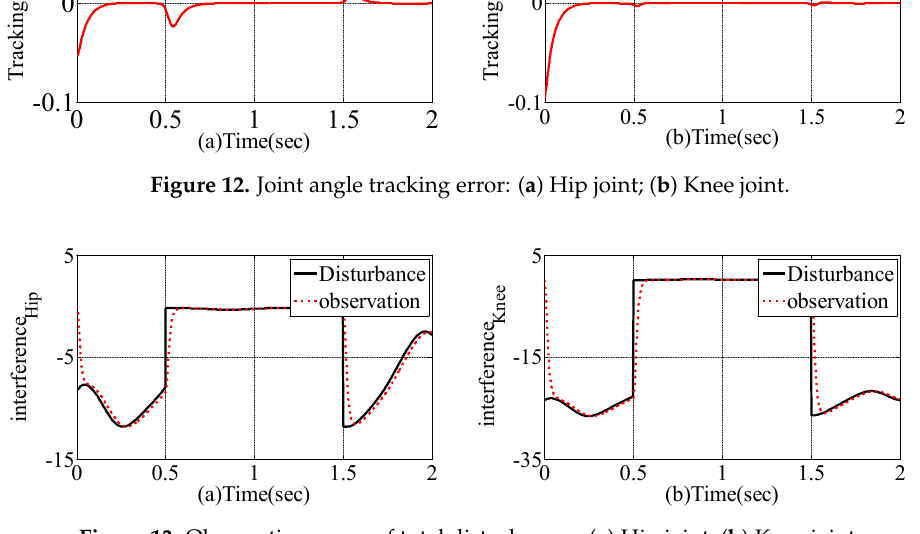
Figure 13. Observation curve of total disturbances: ( a ) Hip joint; ( b ) Knee joint.